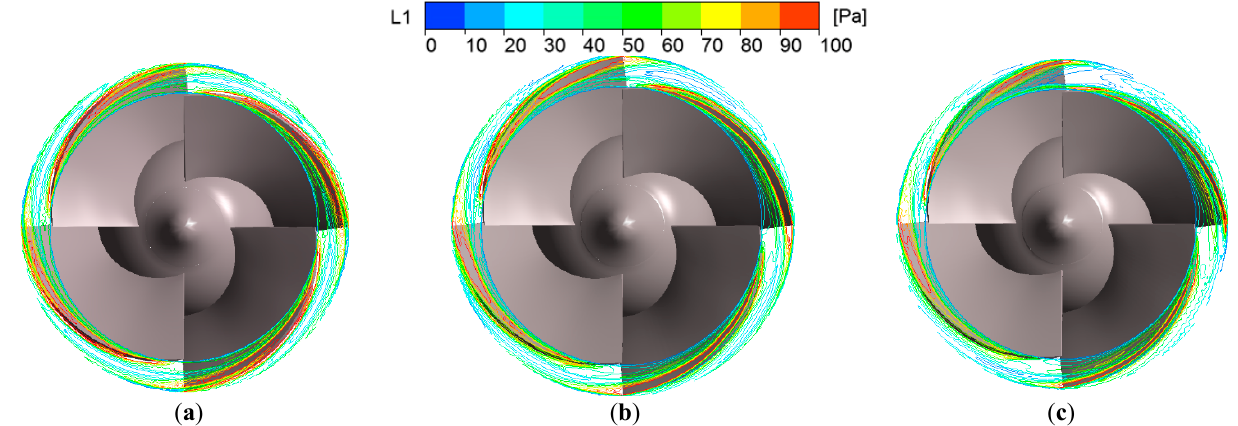
Figure 14. Distribution of L 1 in runner end wall area with non-uniform tip clearance (span = 0.99). ( a ) e = 0 mm, ( b ) e = 3 × 10 − 1 mm, ( c ) e = 5 × 10 − 1 mm.